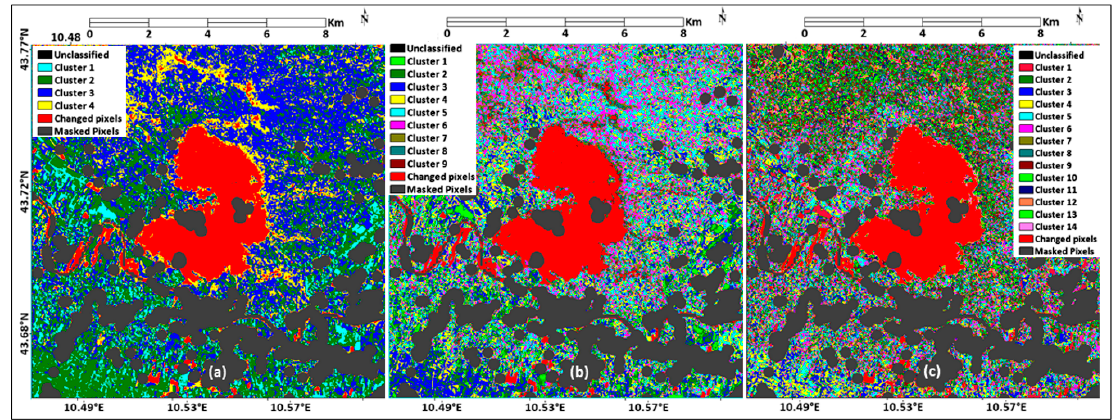
Figure 10. Output of the ISODATA applied to dNBR2 obtained by assuming 5 ( a ), 10 ( b ) and 15 ( c ) as the maximum number of clusters. The EMSR316 test case is considered.